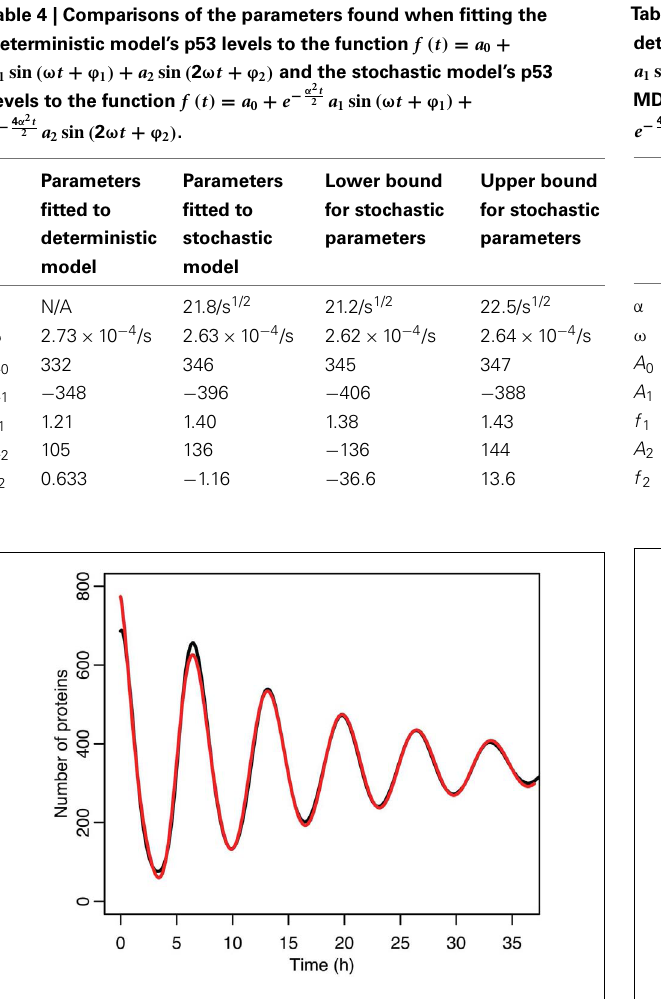
FIGURE 9 |A comparison of the function [ p 53 ] 1.8 between the k 1.8 d +[ p 53 ] 1.8 function applied to mean p53 values in black and the mean of the function when applied to the distribution of p53 values in